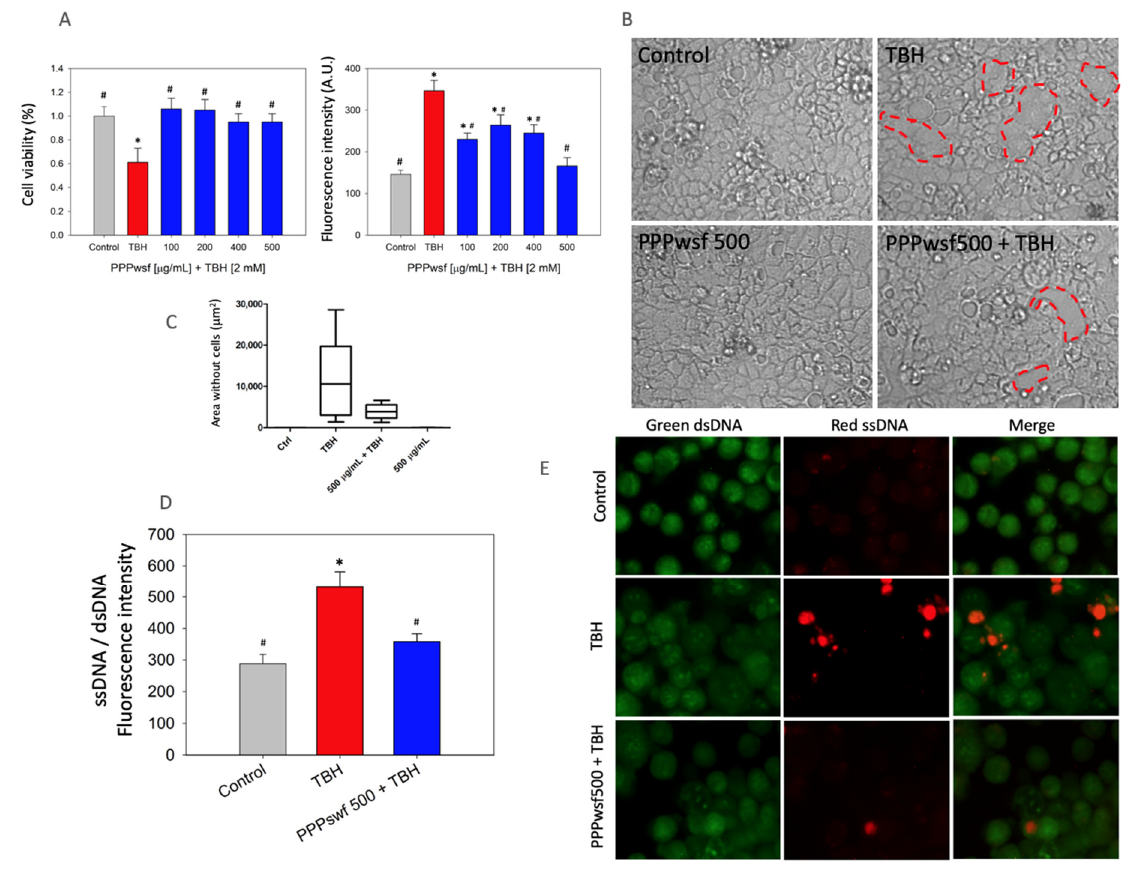
Figure 3. PPPwsf co-treatment in Caco-2 cells: ( A , left) Cell viability of Caco-2 cells and ( A , right) fluorescence intensity values due to the ROS presence in Caco-2 cells, 4 h after the addition of PPPwsf at the concentration of 100 μ g/mL, 200 μ g/mL, 400 μ g/mL, and 500 μ g/mL together with TBH 2 mM. Cell viability data are reported as percentage with reference to the control value. * Control vs. other treatments ( p ≤ 0.05); # TBH samples vs. control and other treatments ( p ≤ 0.05). ( B ) Microscopic inspection of the Caco-2 cell layer treated with TBH alone (positive control) and after the complete co-treatment with PPPwsf500 and TBH 2 mM. The dashed red lines circumscribe the area without cells. Control and PPPwsf500-treated cells are also reported. ( C ) Plot of the values of the areas of the Caco-2 layer without cells. ( D ) Fluorescence intensity of the ratio between red and green fluorescence intensities in Caco-2 cells 4 h after co-treatment with PPPwsf500 and TBH 2 mM and staining with orange acridine. * Control vs. other treatments ( p ≤ 0.05); # TBH samples vs. control and other treatments ( p ≤ 0.05). ( E ) Microscopic fluorescence signals after orange acridine staining of the Caco-2 cells 4 h after co-treatment with PPPwsf500 and TBH 2 mM. Data concerning the control and TBH alone were also reported. Magnification 40 ×